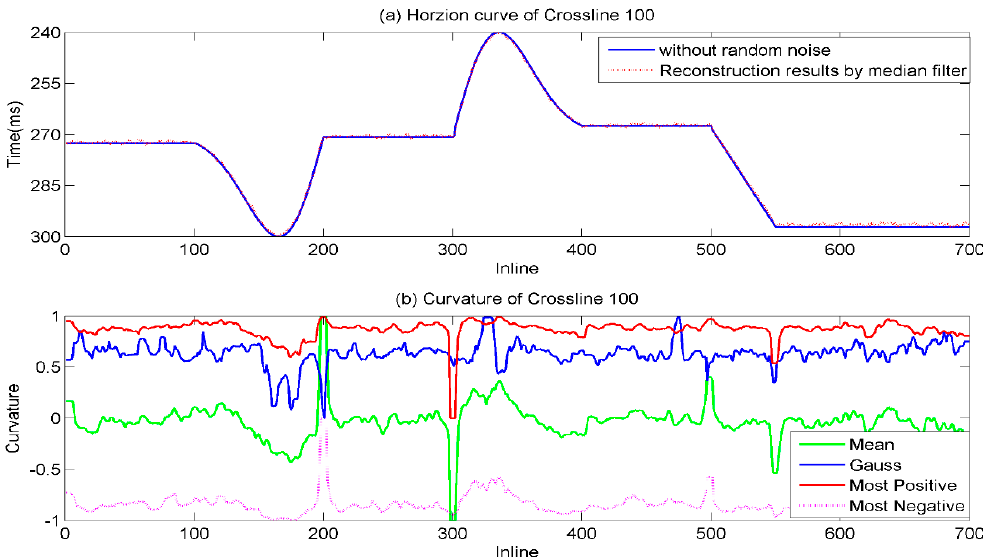
Figure 13 . Horizon curve and curvature attributes: ( a ) Reconstruction results of horizon curve by median filter and ( b ) curvature attributes after denoising based on median filter.